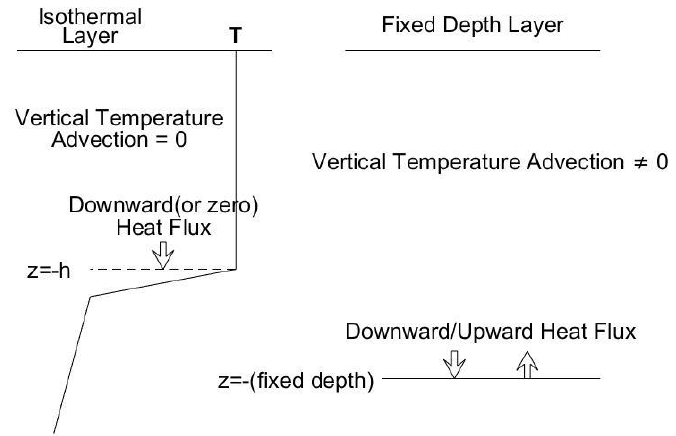
Figure 7. Comparison between ocean heat content (OHC) for the isothermal layer and fixed-depth layer.